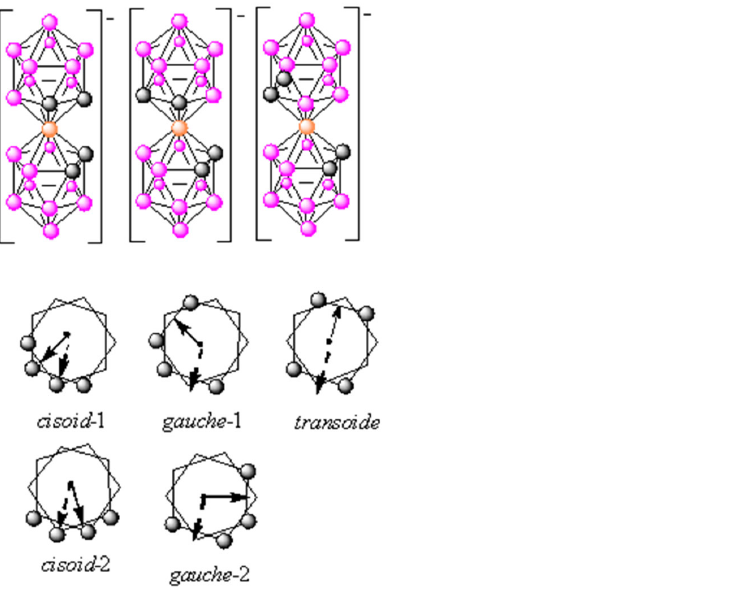
Figure 1. Schematic representation of the icosahedral anionic cobaltabis(dicarbollide) cluster [3,3 ′‐ Co(1,2 ‐ C 2 B 9 H 11 ) 2 ] − conformers (the arrows indicate the direction of dipole moments of compounds). Circles in grey represent the C c ‐ H vertices; the orange ones correspond to metal (M = Co 3+ , Fe 3+ ), while the circles in pink correspond to B ‐ H vertices.